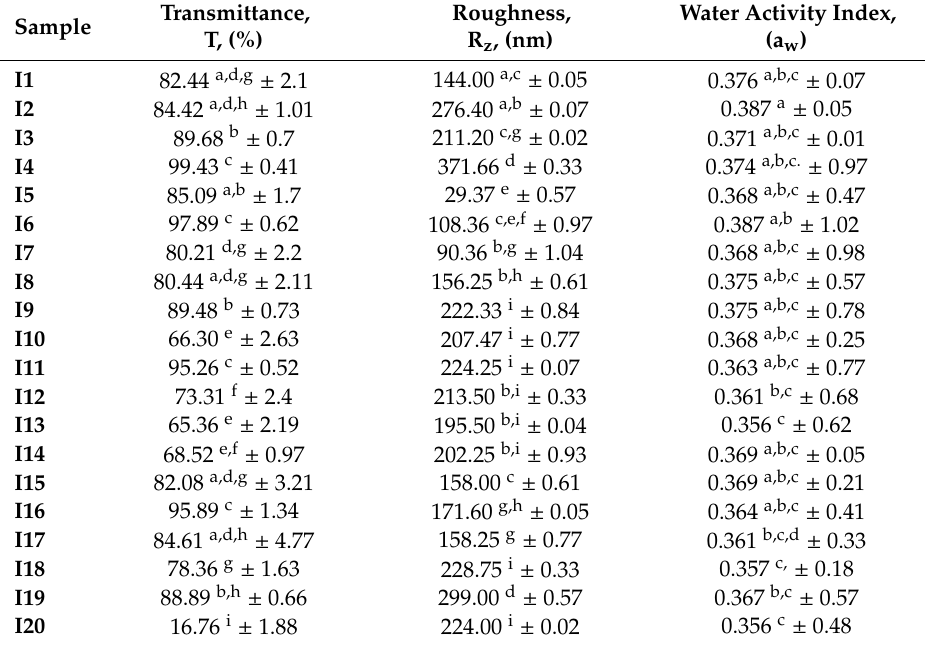
Table 1. Tested films